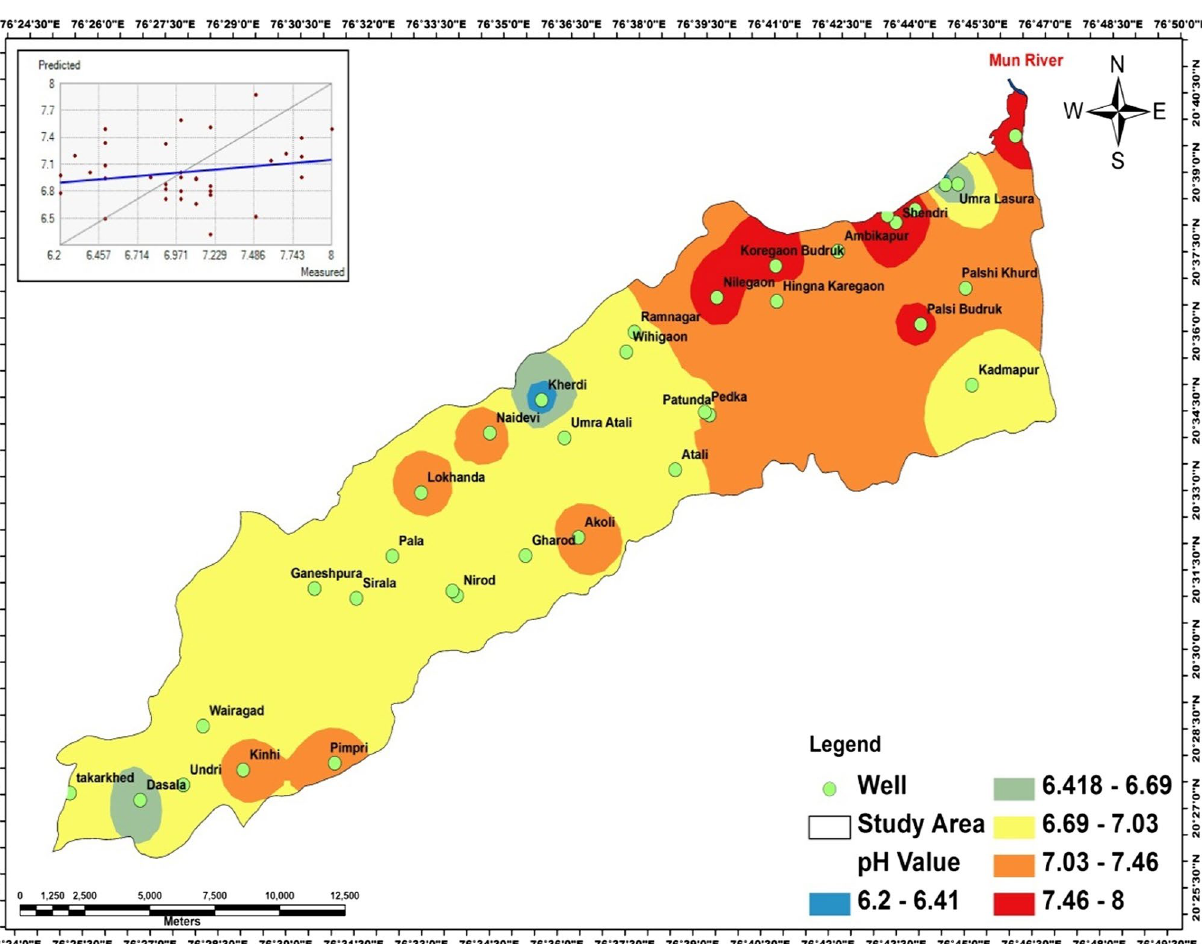
Fig. 3 Spatial distribution map of pH post